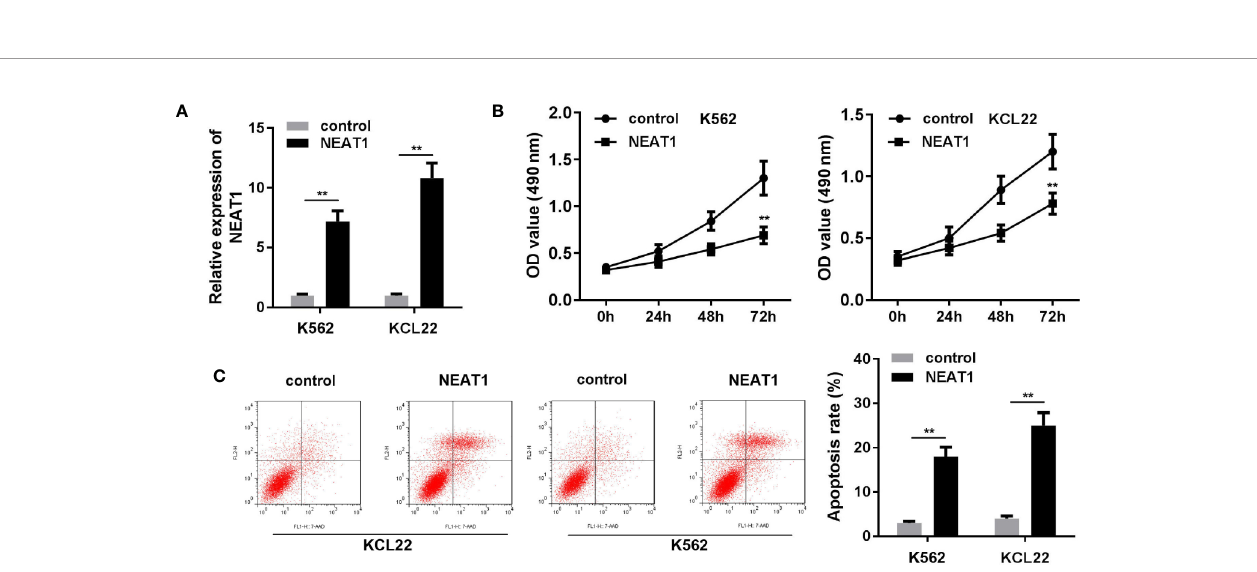
FIGURE 2 | Overexpression of NEAT1 suppresses cell viability and inhibited the apoptosis in CML cells. (A) The expression of NEAT1 in CML cells. (B) Cell viability after incubation for 0, 24, 48, 72 h in the cells transfected with NEAT1/pcDNA3.1. (C) The apoptosis rates of CML cells. **P < 0.01 vs. control. NEAT1, lncRNA nuclear enriched abundant transcript